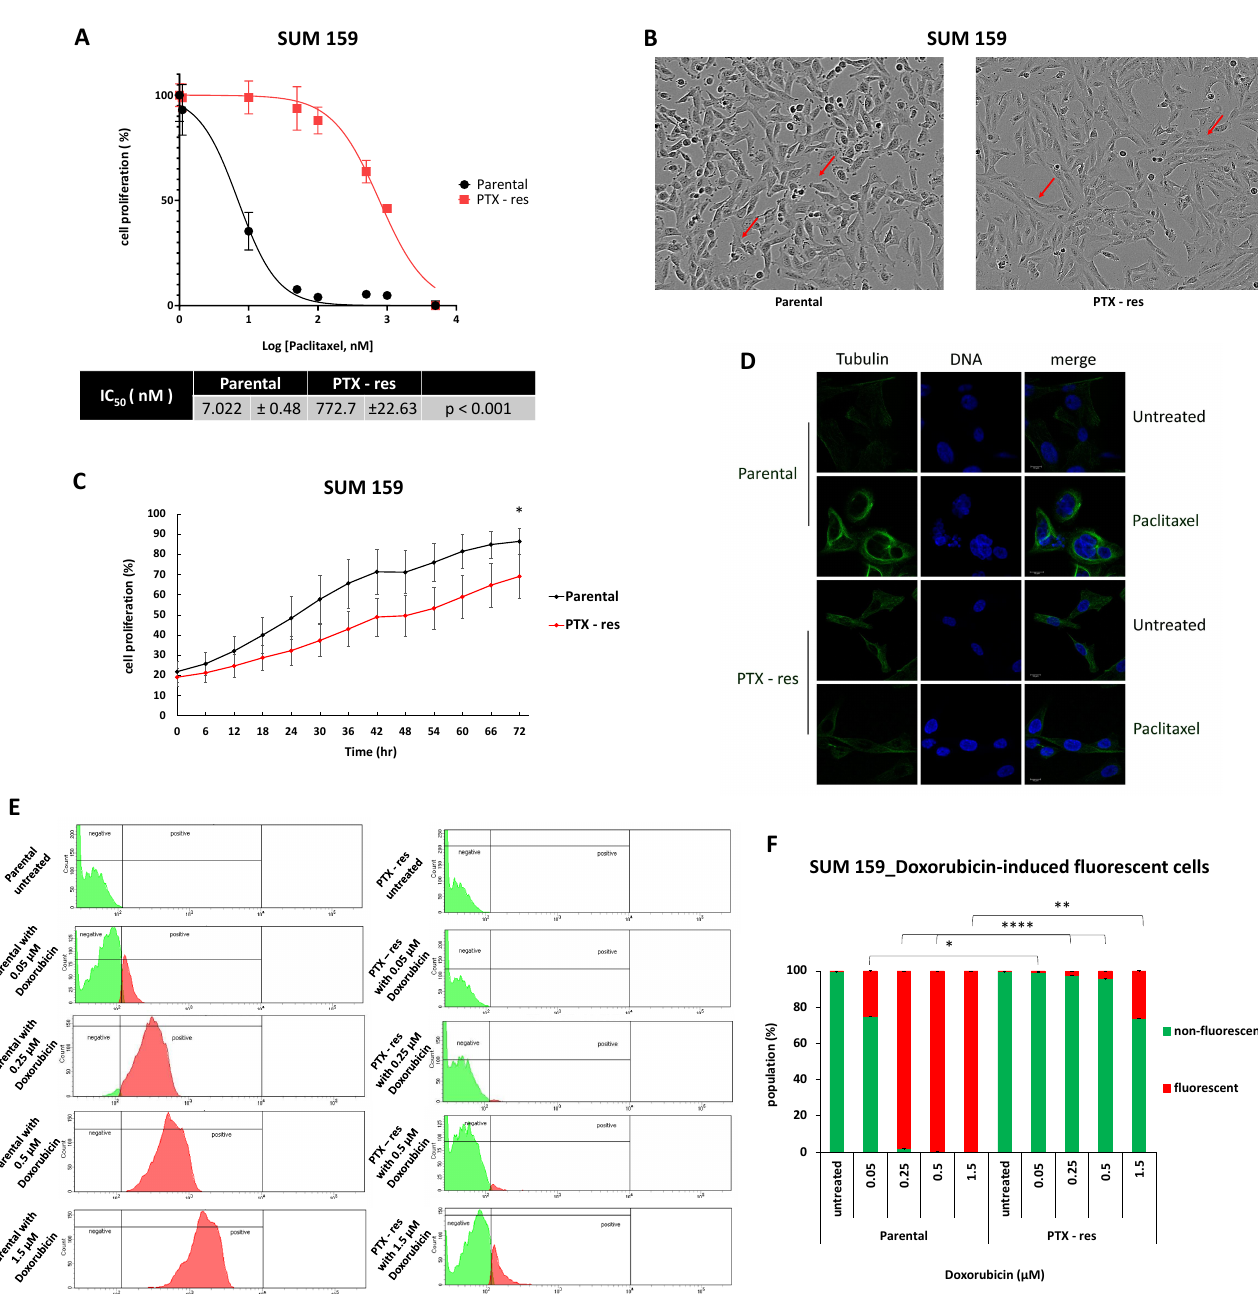
Figure 1. Establishment and characterization of SUM159 paclitaxel-resistant (PTX-res) cells. ( A ) The generated cell line (PTX-res) demonstrates > 100-fold resistance, compared to the parental cells, when treated with paclitaxel, as shown by their IC 50 values. ( B ) The establishment of the drug-resistant phenotype in SUM159 cells is associated with alterations in cellular morphology. ( C ) Growth kinetics assay for SUM159 parental and PTX-res cells grown in culture for three days. ( D ) Immunofluorescence staining for SUM159 parental and PTX-res cells with an antibody against tubulin (green) or TORPO3 (blue). ( E ) FACS analysis in SUM159 parental and PTX-res cells for intracellular uptake of doxorubicin (red fluorescence) after a 6-hour incubation with different drug concentrations. ( F ) Quantification of FACS analysis presented in ( E ). Error bars indicate the SEM of biological replicates (n = 3). *: p < 0.05, **: p < 0.01, ****: p <